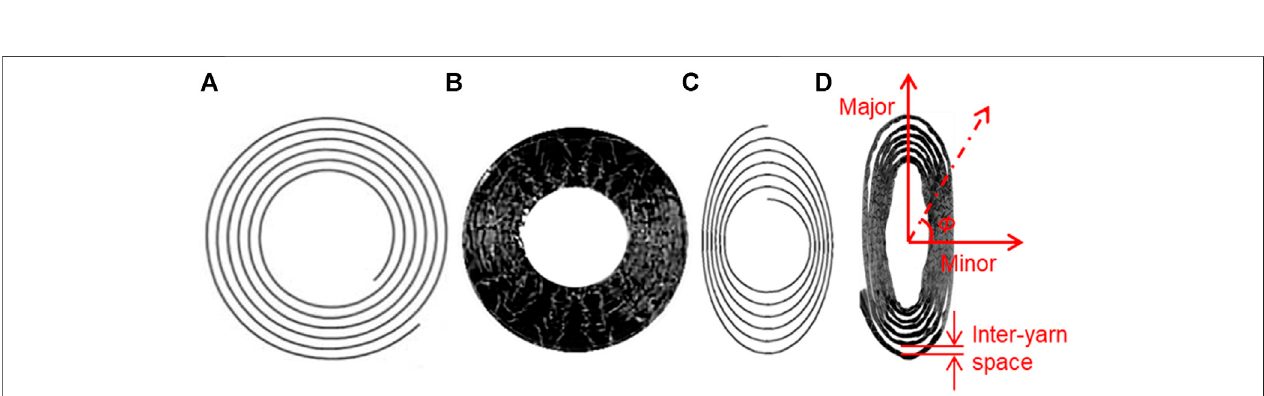
FIGURE 2 | TFP patches: (A,C) TFP patterns designed in CAD software; (B,D) stitched yarns (Gliesche et al., 2003).